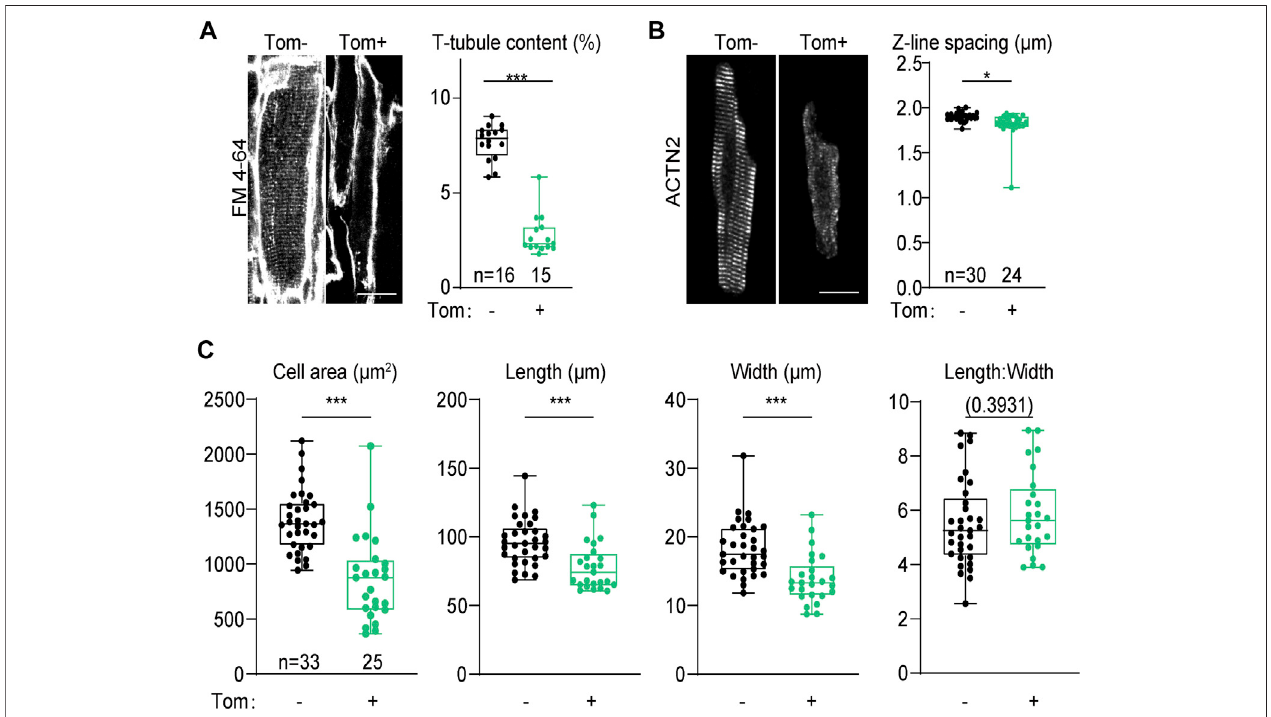
FIGURE 5 | Morphological analysis of cardiomyocytes from the genetic mosaic hearts . (A) , In situ confocal images of cardiomyocytes stained with FM 4 – 64 and AutoTT quanti fi cation of T-tubule contents. (B) , Confocal images of isolated cardiomyocytes immunolabeled with an ACTN2 antibody and quanti fi cation of Z-line distance.In A and B ,scalebar,20 μ m. (C) , Geometric measurement ofisolatedcardiomyocytes.Tom, tdTomato. Unpairedtwo-tailedstudent ’ st-test: * p < 0.05, *** p < 0.001, non-signi fi cant p values in parenthesis.